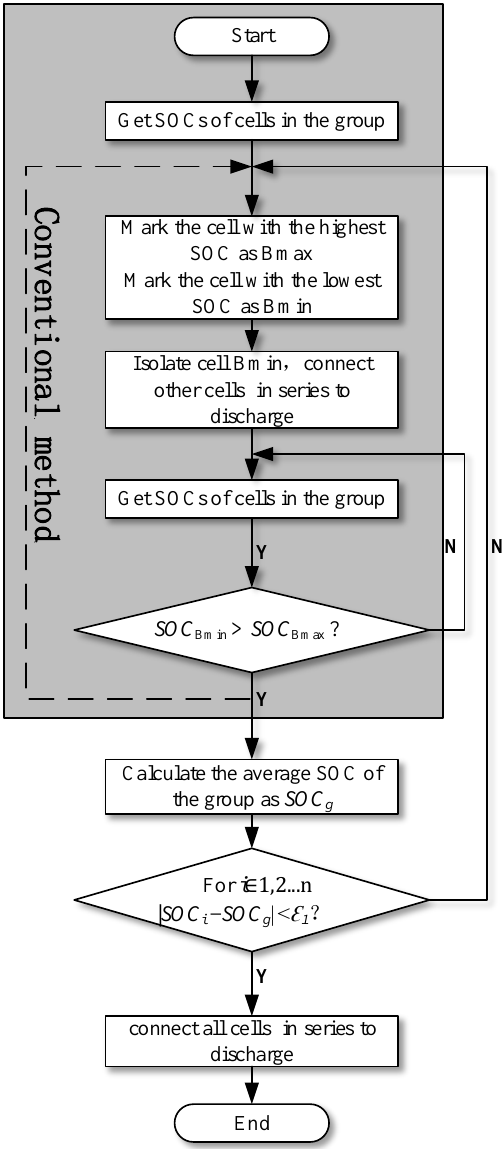
Figure 6. Control strategy of conventional method (shaded area, dotted line)/control strategy of the proposed inner layer.